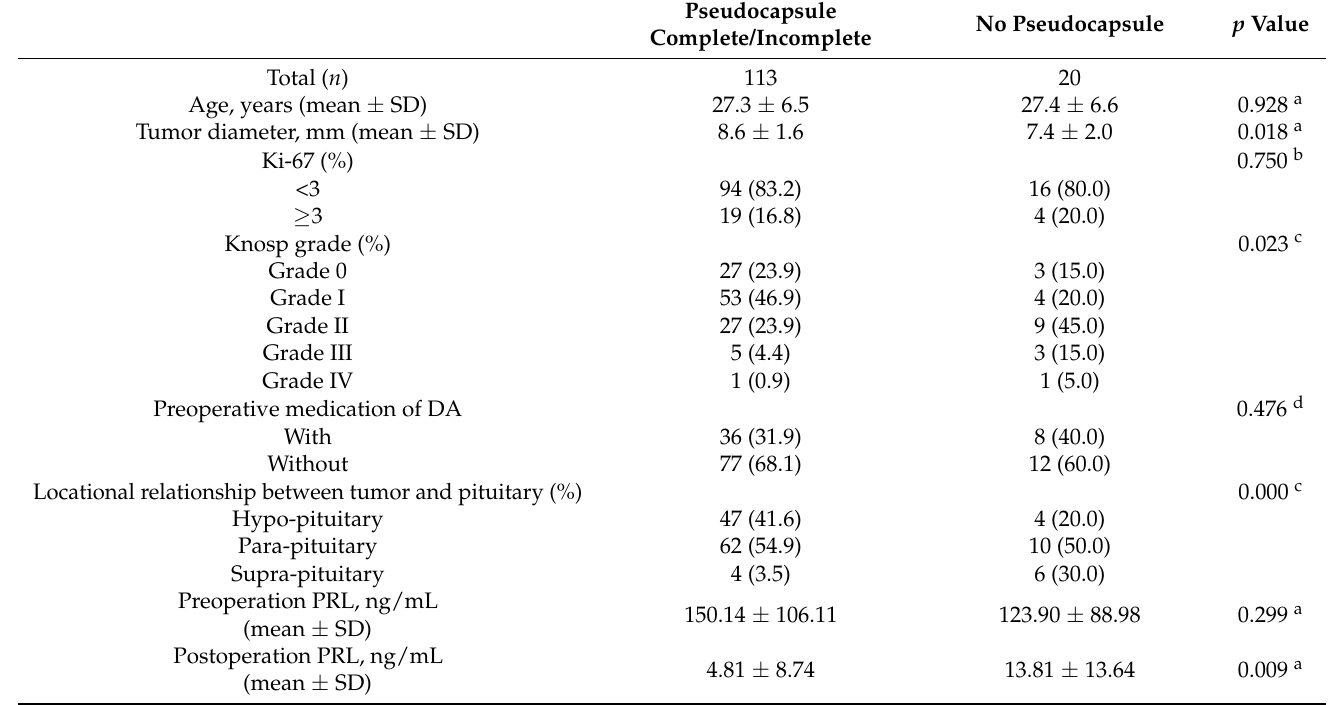
Table 4. Baseline characteristics of 20 female patients with lack of